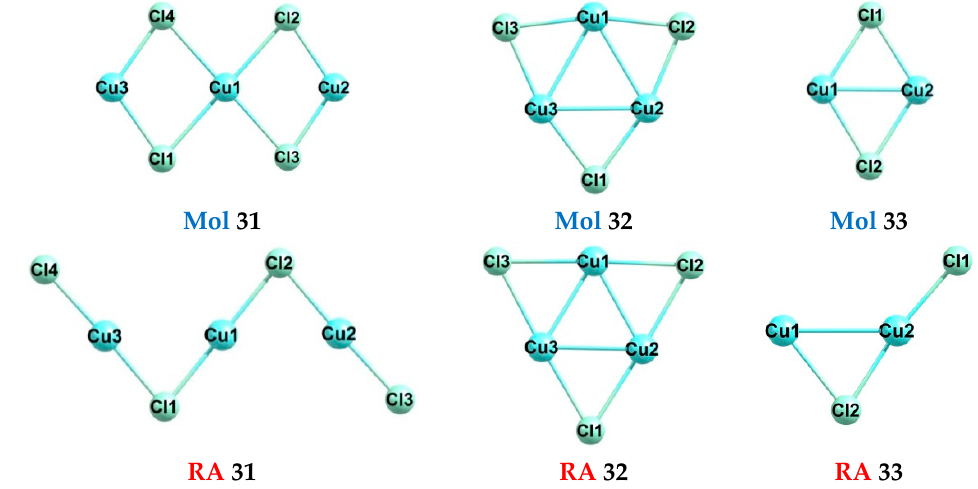
Figure 7. The DFT calculated molecules ( Mol ) and radical anions ( RA ). Table 2. Experimental and DFT calculated adiabatic electron affinities (AEA, eV) and DFT calculated energies (E, E h ) of molecules ( Mol ) and radical anions ( RA ) of 31 – 33 *. Formula No. Exp.